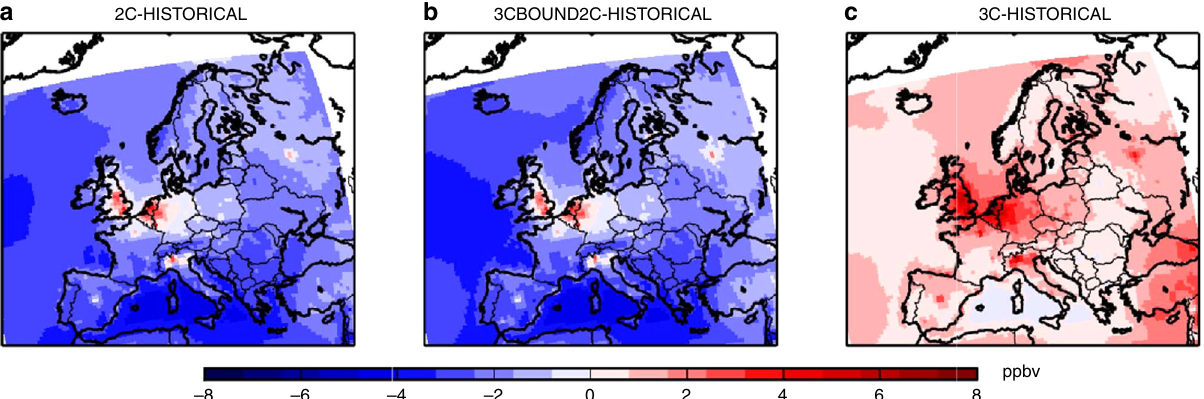
Fig. 2 Differences of mean annual ozone concentrations. Differences of mean annual ozone concentrations of a 2C minus HISTORICAL, b 3C-BOUND2C minus HISTORICAL, and c 3C minus HISTORICAL. The means are calculated from the 30-year period of the different scenarios. Units are ppbv. The different scenarios are described in Table 1. This fi gure has been generated using the Matplotlib library for the Python programming language